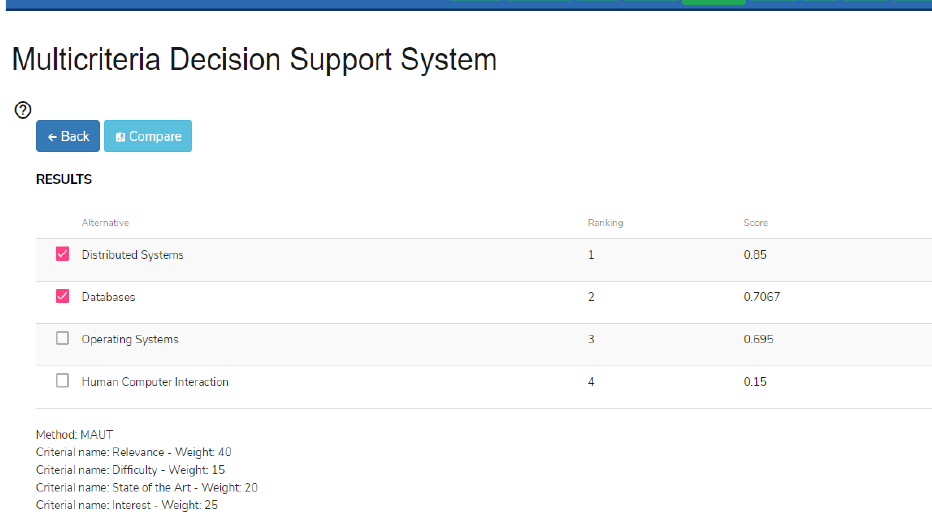
Figure 7. MAUT method results.